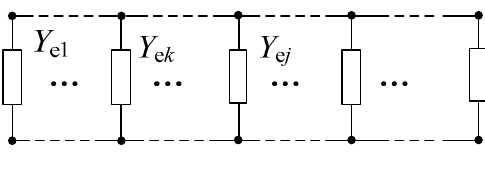
Figure 6. Admittance network.